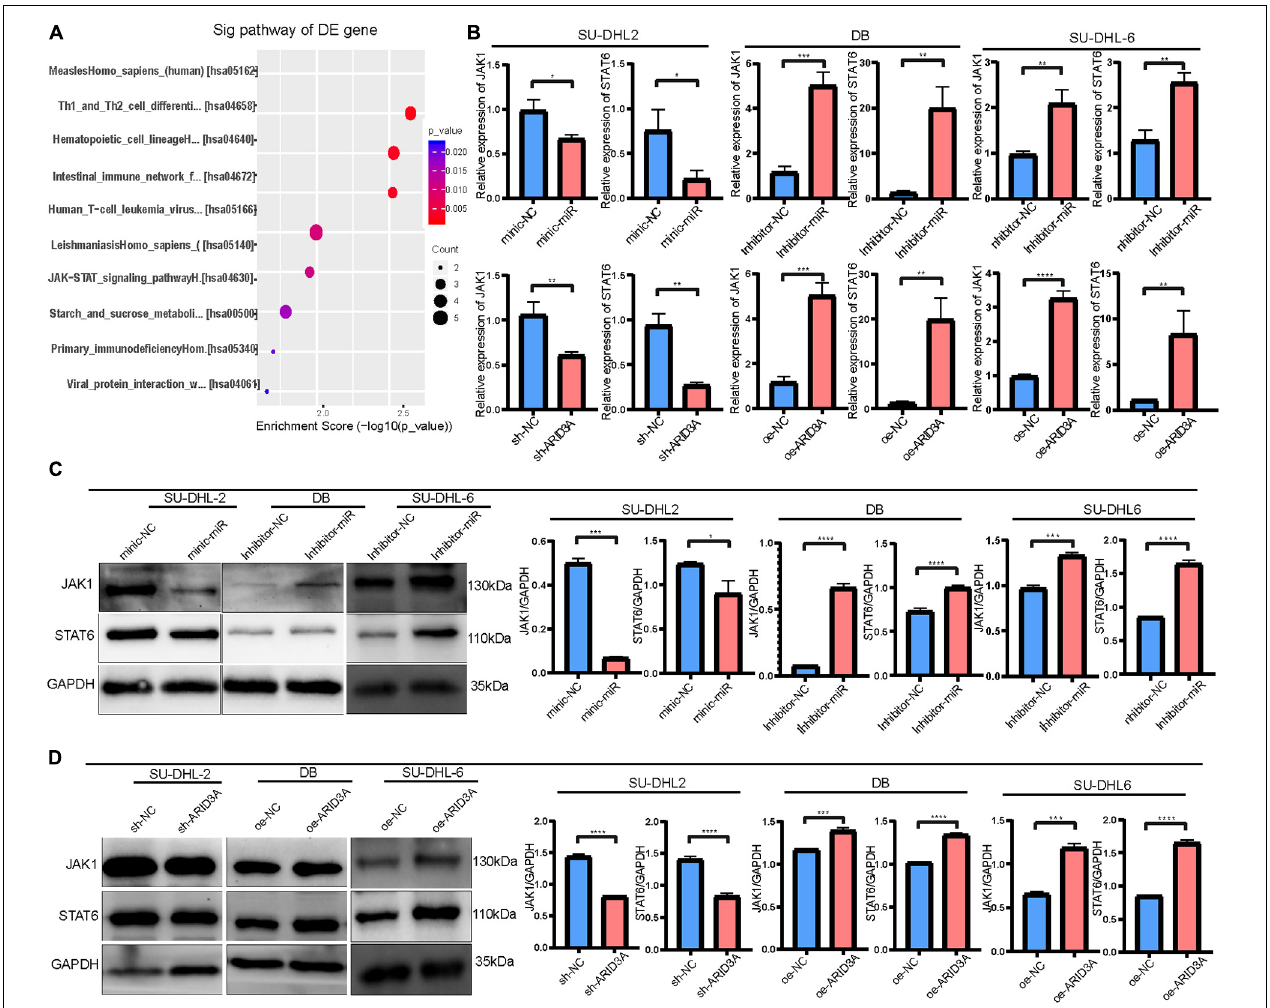
FIGURE 6 | MiR-129-5p and ARID3A target the Janus kinase-signal transducer and activator of transcription (JAK-STAT) signaling pathway. (A) Differentially intersected genes were subjected to KEGG pathway analysis. (B) JAK1 and STAT6 mRNA levels in transfected DB, SU-DHL-2 and SU-DHL-6 cells were determined using RT-qPCR. (C,D) Western blotting and densitometric analyses showing JAK1 and STAT6 protein levels in transfected DLBCL cells. All data represented mean ± SD from three independent experiments. * P < 0.05, ** P < 0.01; *** P < 0.001; **** P <